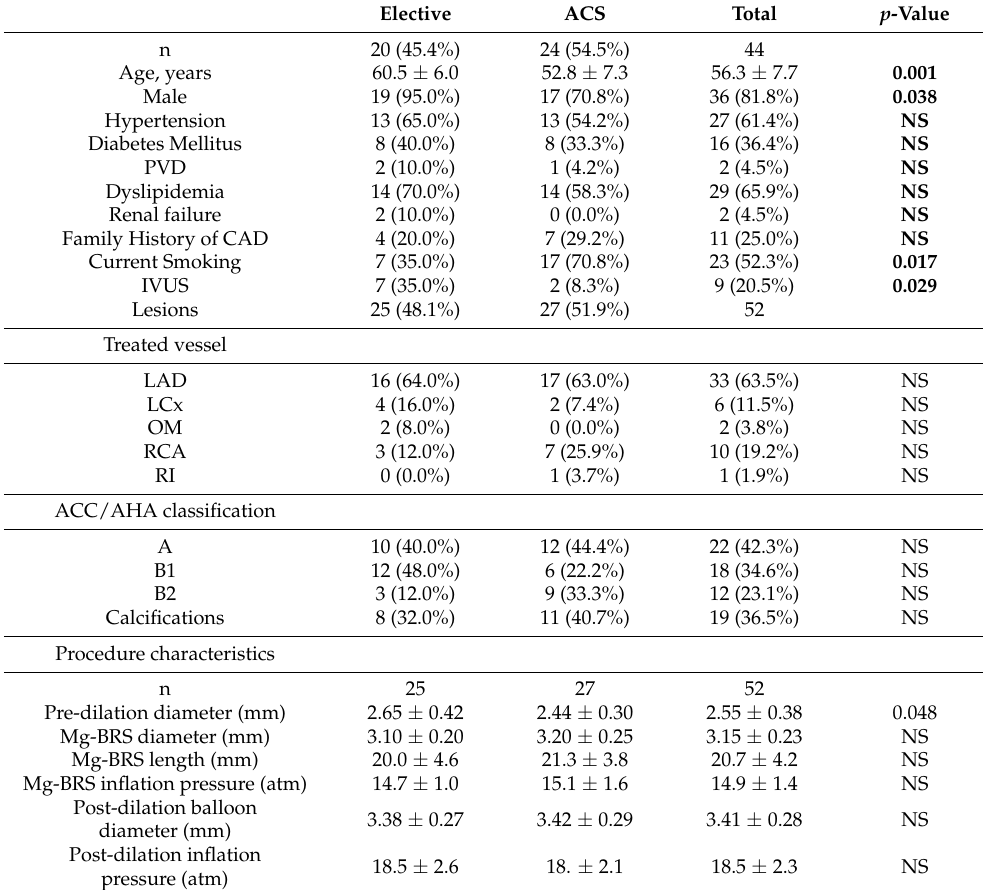
Table 2. General patient and procedure